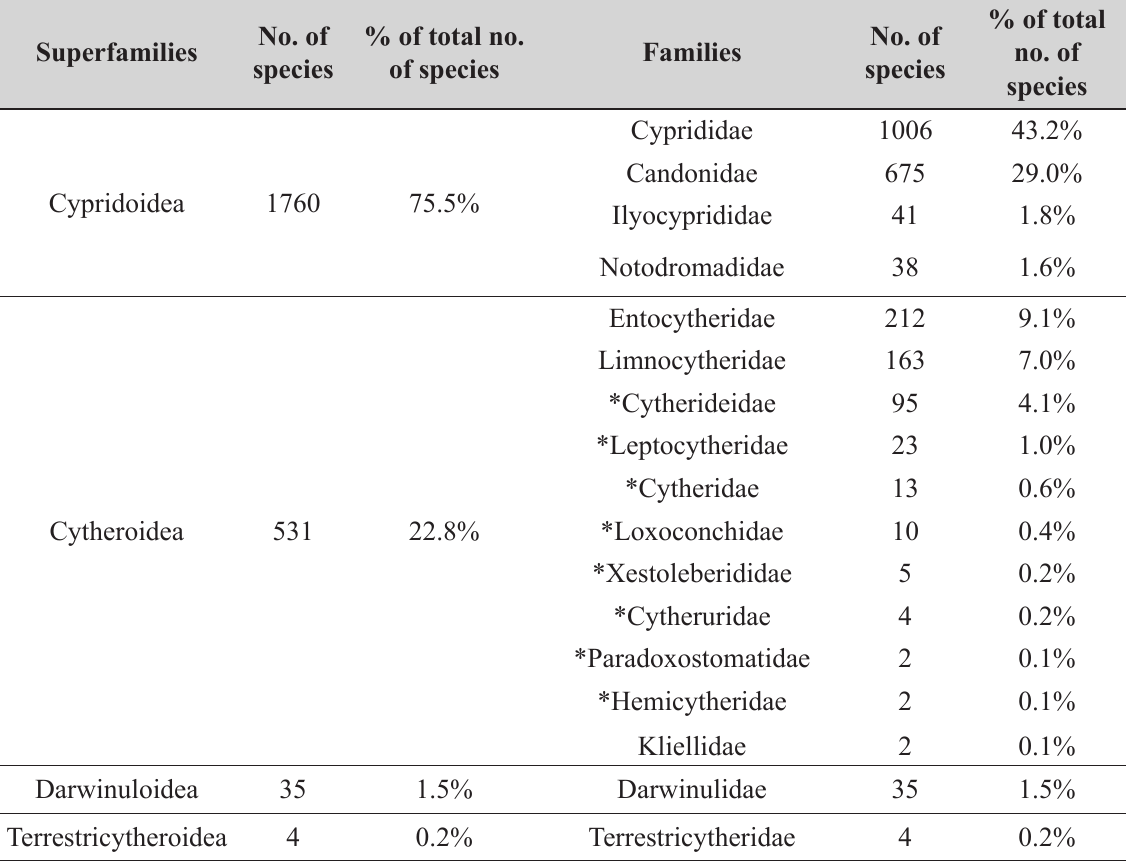
European Journal of Taxonomy 492: 1–135 Table 2. Numbers of non-marine species/subspecies and percentages of total number of species in superfamilies and families. *indicates primarily marine families with non-marine representatives.